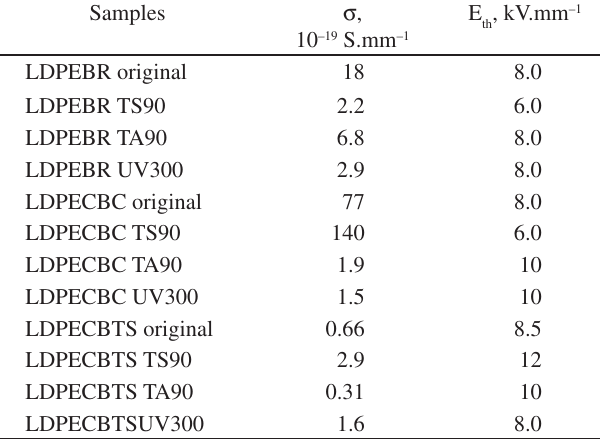
Table 2. Electrical properties measured for the samples after and before ageing